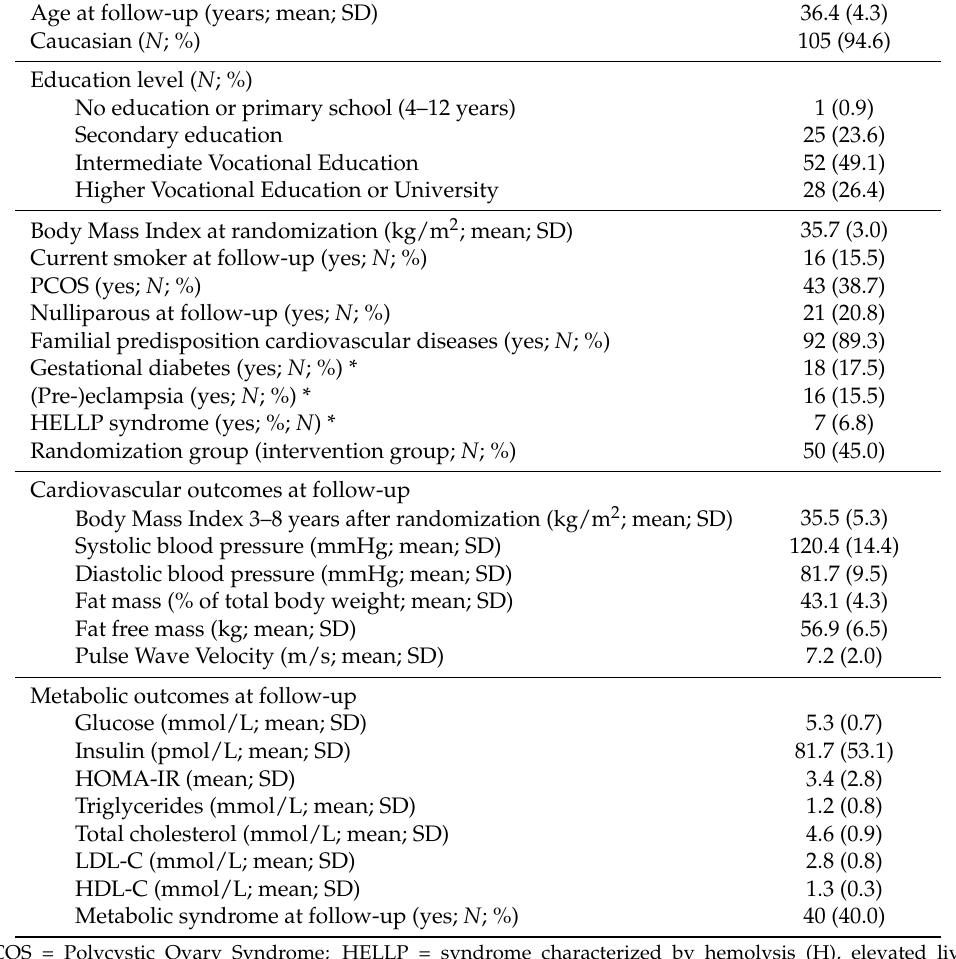
Table 1. Characteristics and cardiometabolic health of the study population ( N =